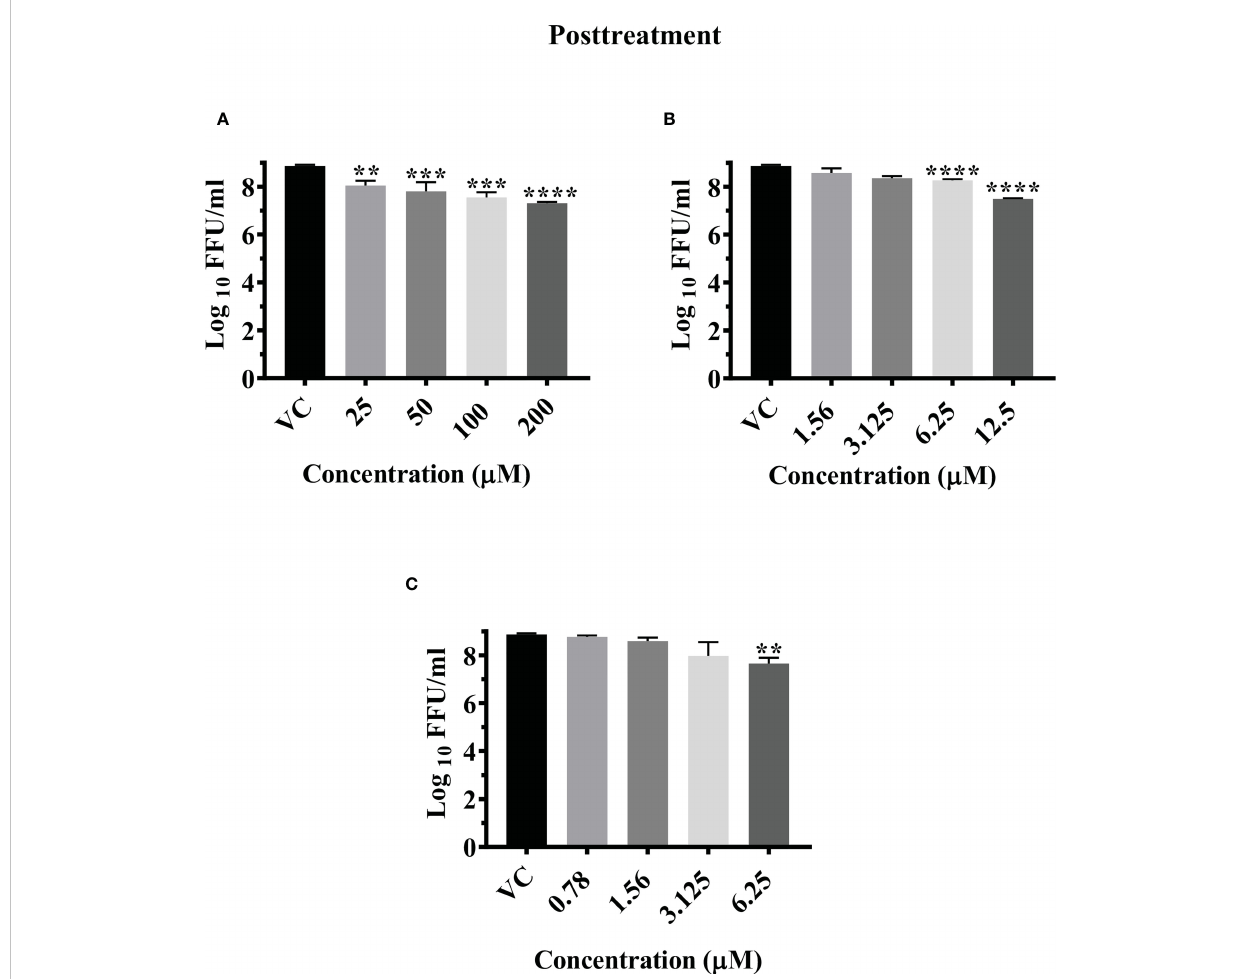
FIGURE 5 Antiviral effect of emetine (A) , resveratrol (B) and lomibuvir (C) against CHIKV under posttreatment condition using IFA. Infected Vero CCL-81 cells were treated with different concentrations of drug post infection and incubated for 24 hours and plates were frozen and culture supernatants were used for the FFU assay (The trials were carried out in triplicate at two different time points, and the outcomes are expressed as mean log 10 foci forming unit/ml ± standard error). All the treatment conditions were compared with the VC. **** (p<0.0001), ***(p<0.001),